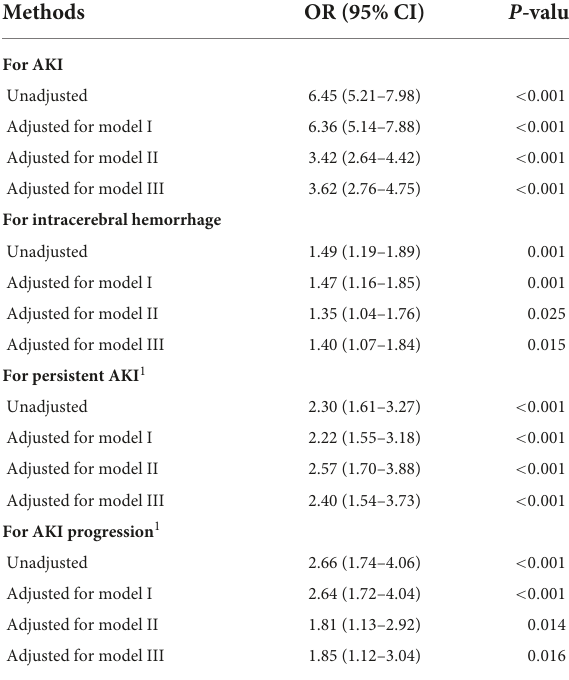
TABLE 5 Univariate and multivariate logistic regression analyses for clinical outcomes.